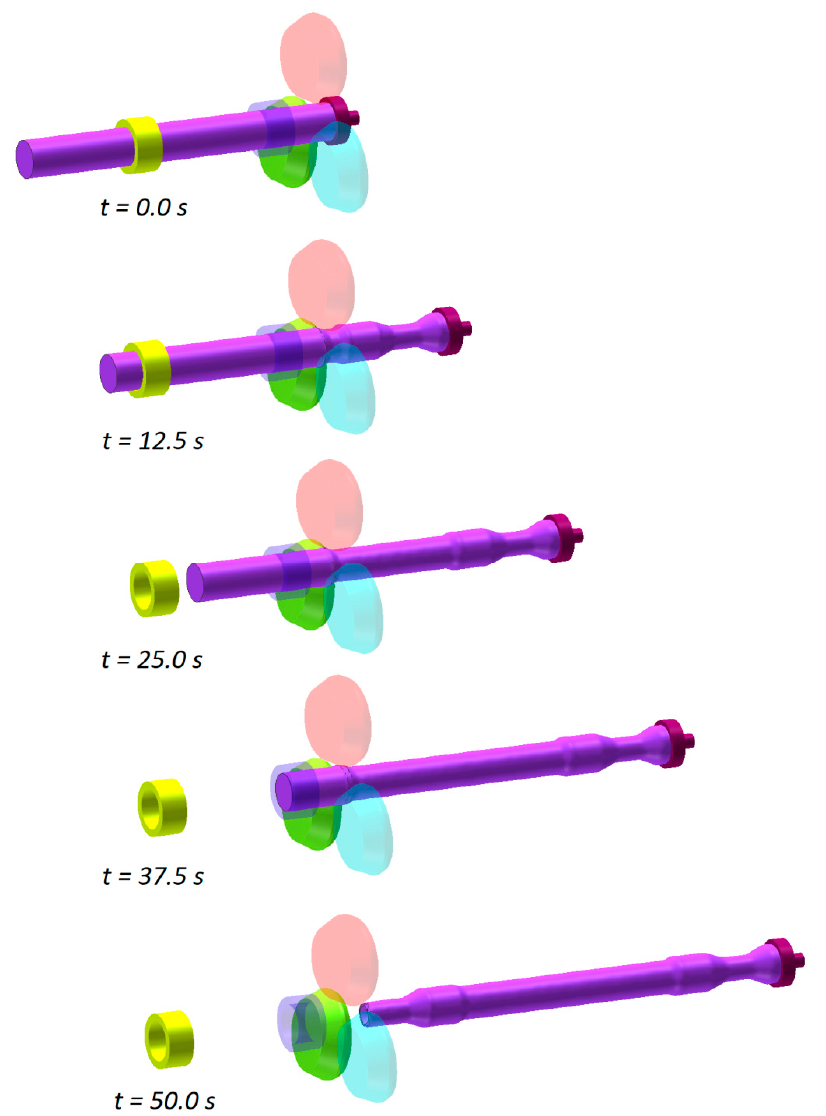
Figure 5. Skew rolling a solid axle in a 3-roll rolling mill.